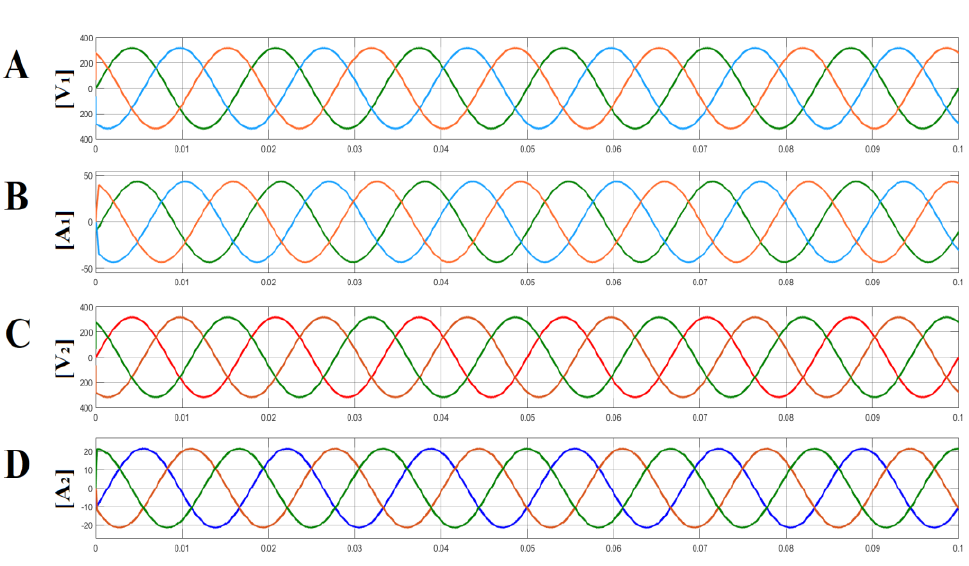
Figure 13. The waveform of the active power of DGs for parallel operation in GC mode.